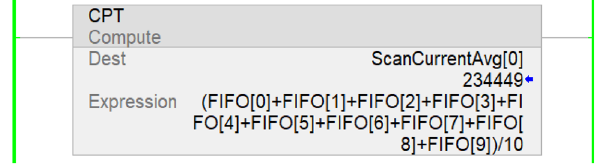
Fig. 23 The average scan time was computed